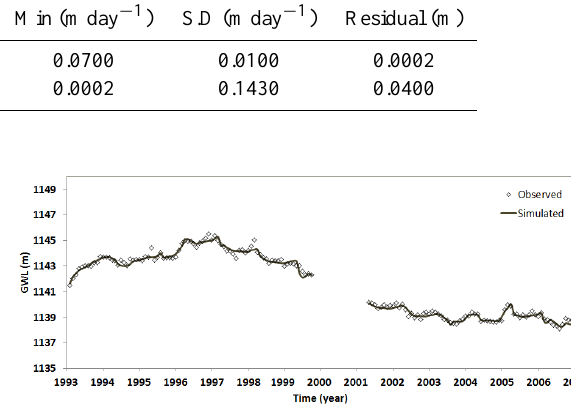
Fig. 7. The average observed and simulated groundwater level (GWL) for all observation wells (due to missing data in two observation wells during 2000 to 2001, no simulation was done for this period).